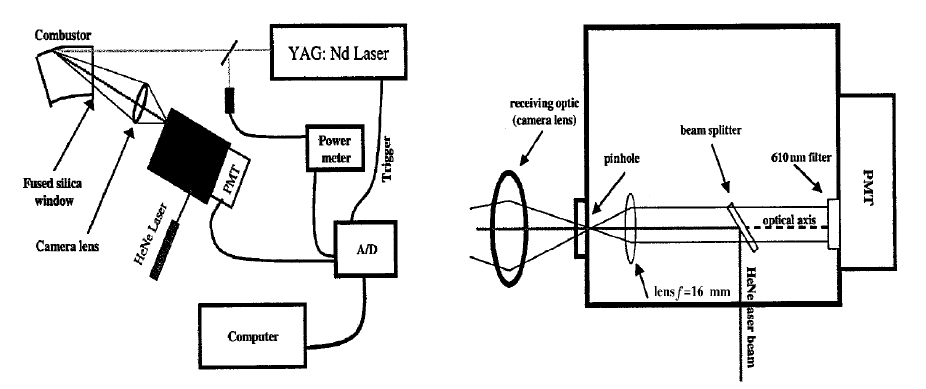
Figure 45. Optical arrangement for combustor measurement [22].